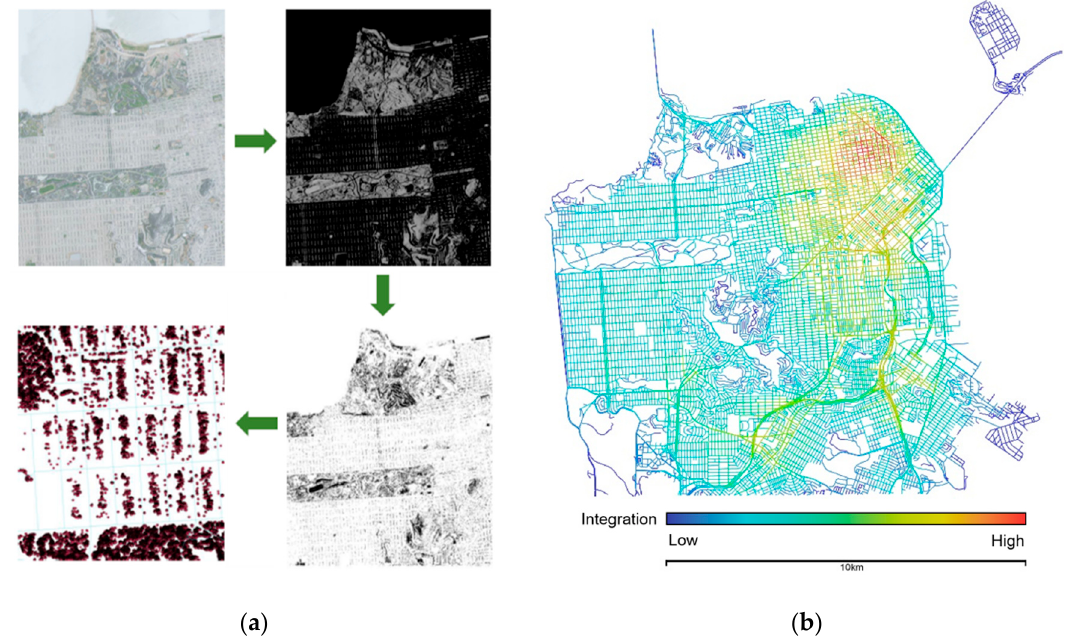
Figure 2. Analyses of collected data from San Francisco. ( a ) NDVI analysis process (aerial image–band manipulation–vectorization–close-up view); ( b ) Angular segment analysis result (integration).